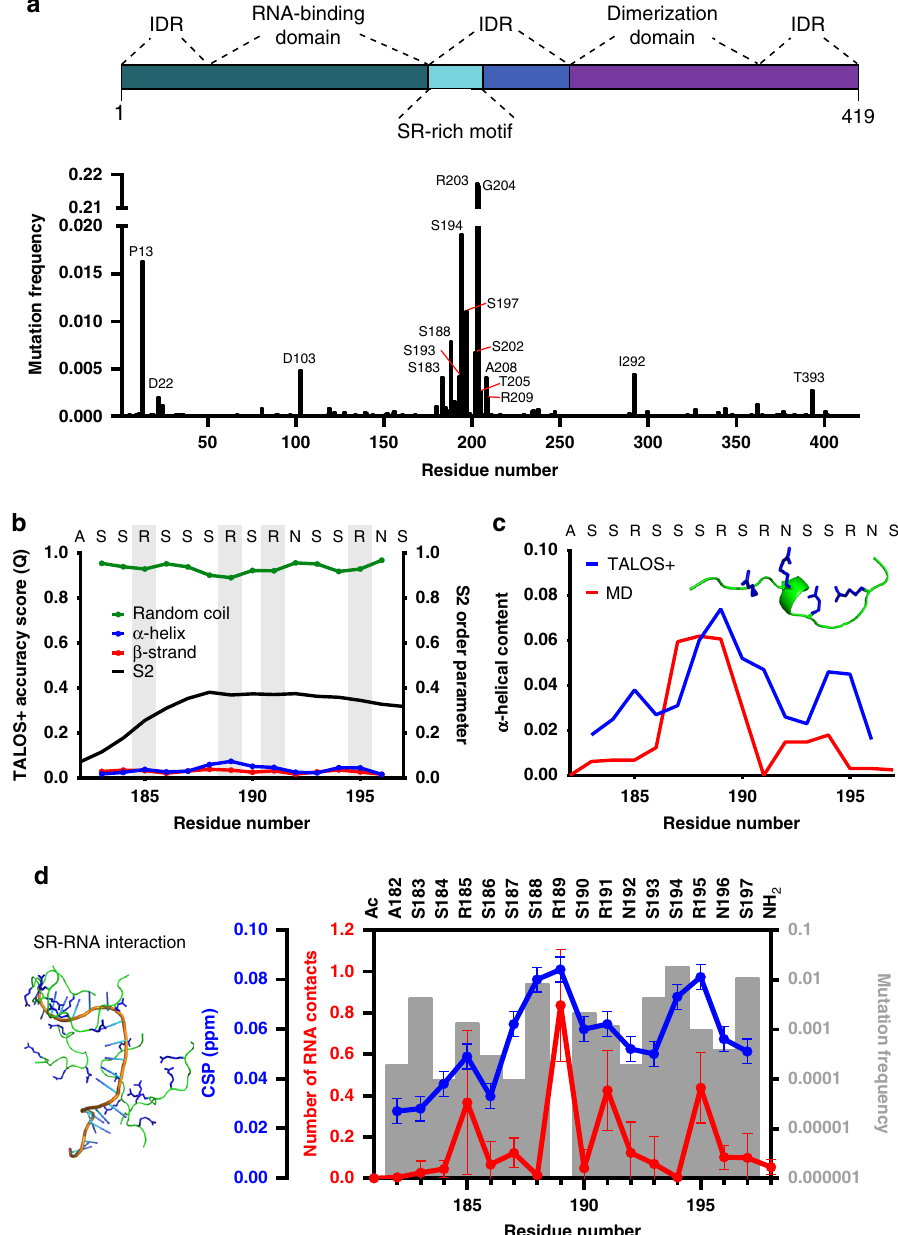
Fig. 3 Atomic details of the RNA-interaction of the mutation-prone SR-region. a Frequency of mutations in the nucleocapsid protein in 42176 SARS-CoV-2 sequences from the China National Center for Bioinformation. Residues with more than 0.0025 frequency are labeled. Domain organization of N SARS-CoV-2 on top. b NMR-based analysis of the structure of the high-density SR-stretch (residues A182-S197) of N SARS-CoV-2 . Secondary structure derived from chemical shifts using TALOS + 36 is represented together with the S 2 order parameter. Arginines are highlighted in gray. c Comparison between the α -helical propensity derived from NMR data (blue) and MD simulations (red). One conformer with α -helical content from the simulation is shown inside the graph. d Comparison between the number of peptide-polyU contacts per peptide in the MD simulations (red; average and standard deviation of fi ve simulations), the NMR chemical shift perturbation (CSP) of the peptide-polyU titration at 1500nM of polyU (blue), and the frequency of mutations per residue (gray bars). At the left, a MD snapshot of fi ve SR-peptides with the 20 base length polyU is